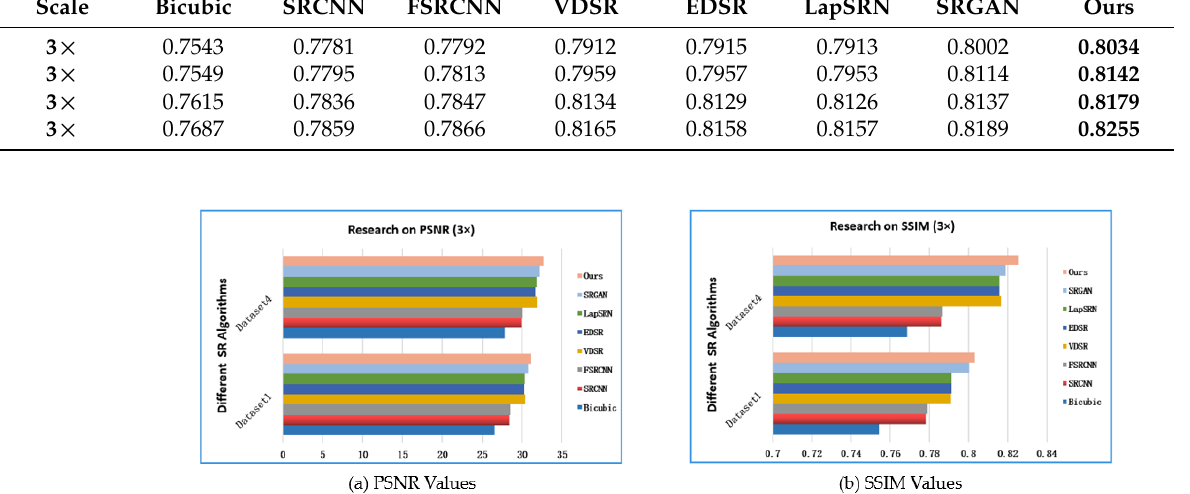
Table 3. Average SSIM on Dataset1, Dataset2, Dataset3 and Dataset4 with different algorithms.